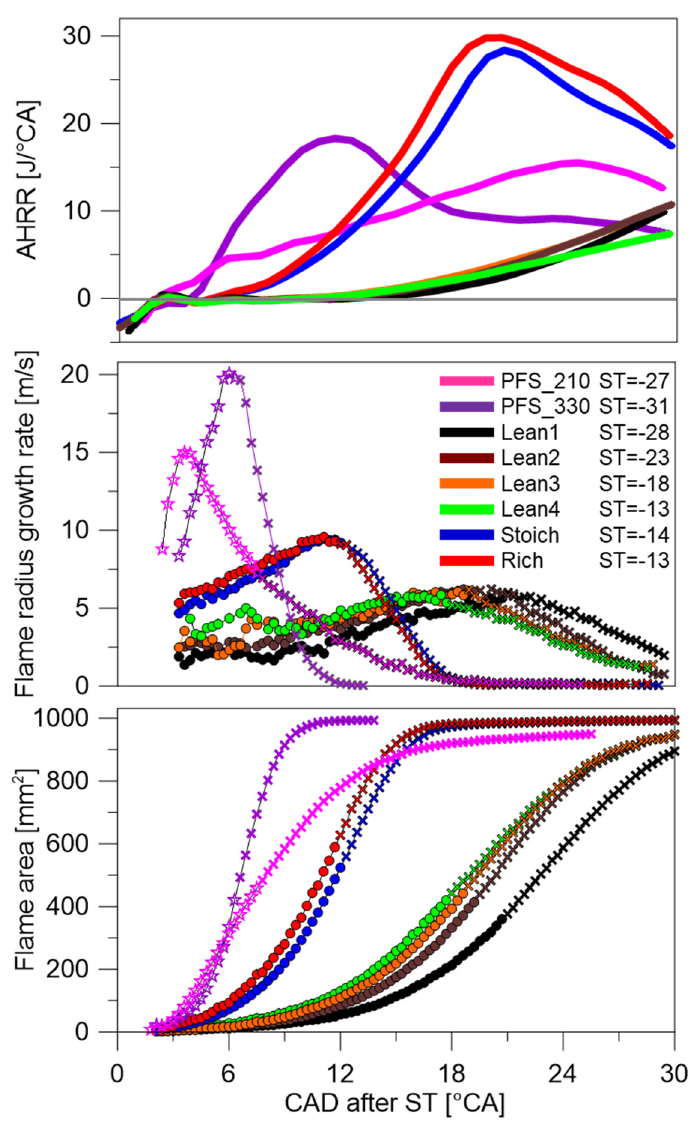
Figure 21. AHRR, rate of flame radius growth and flame area evolution, for well-mixed combustion (with gasoline) and PFS (for gasoline: PFS_330 and E30: PFS_210). Data points corresponding to the CADs where the flame front has approached the limits of the field of view, are represented with crosses.